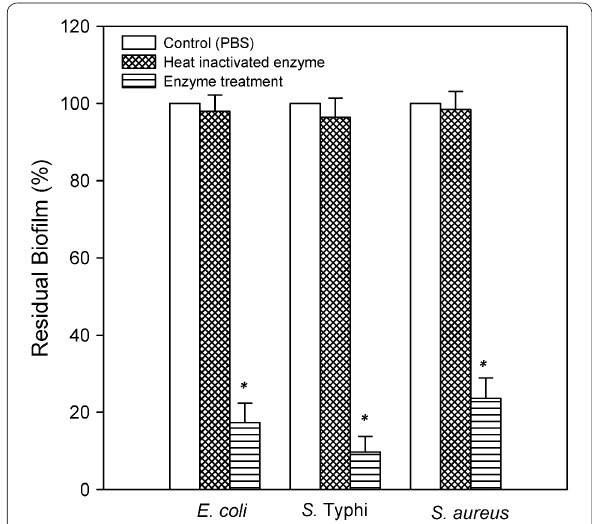
Fig. 2 Residual biofilm (%) after treatment with in-house produced enzyme cocktail. * represents p < 0.0001 versus